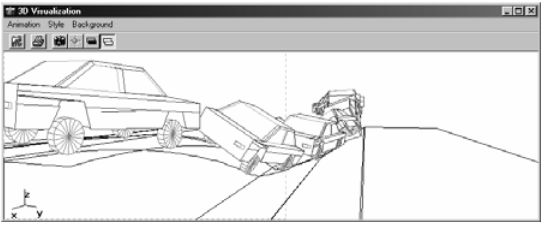
Fig 9. The movement of the automobile from the slope of the road, when the introduced height of the centre of gravity is equal to